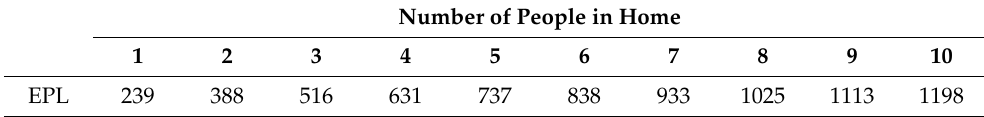
Table 3. Equivalent poverty line (EPL) for homes in Chile, established by MDS [32] (USD).